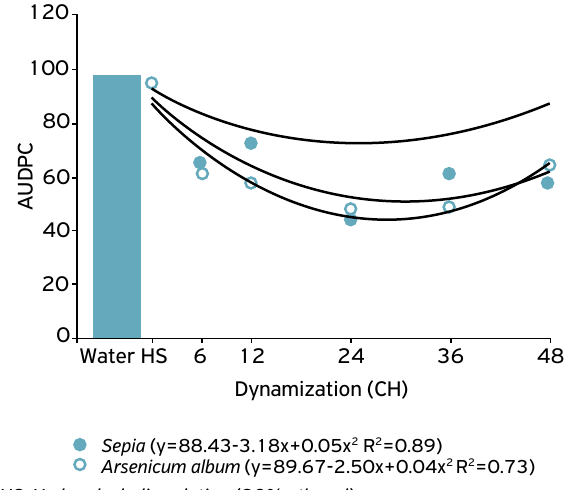
Figure 2. Area under the disease progress curve (AUDPC) of Macrophomina phaseolina from the first experiment carried out in potted soybean plants grown in a greenhouse and treated with dynamizations of the homeopathic drugs, Sepia and Arsenicum album .